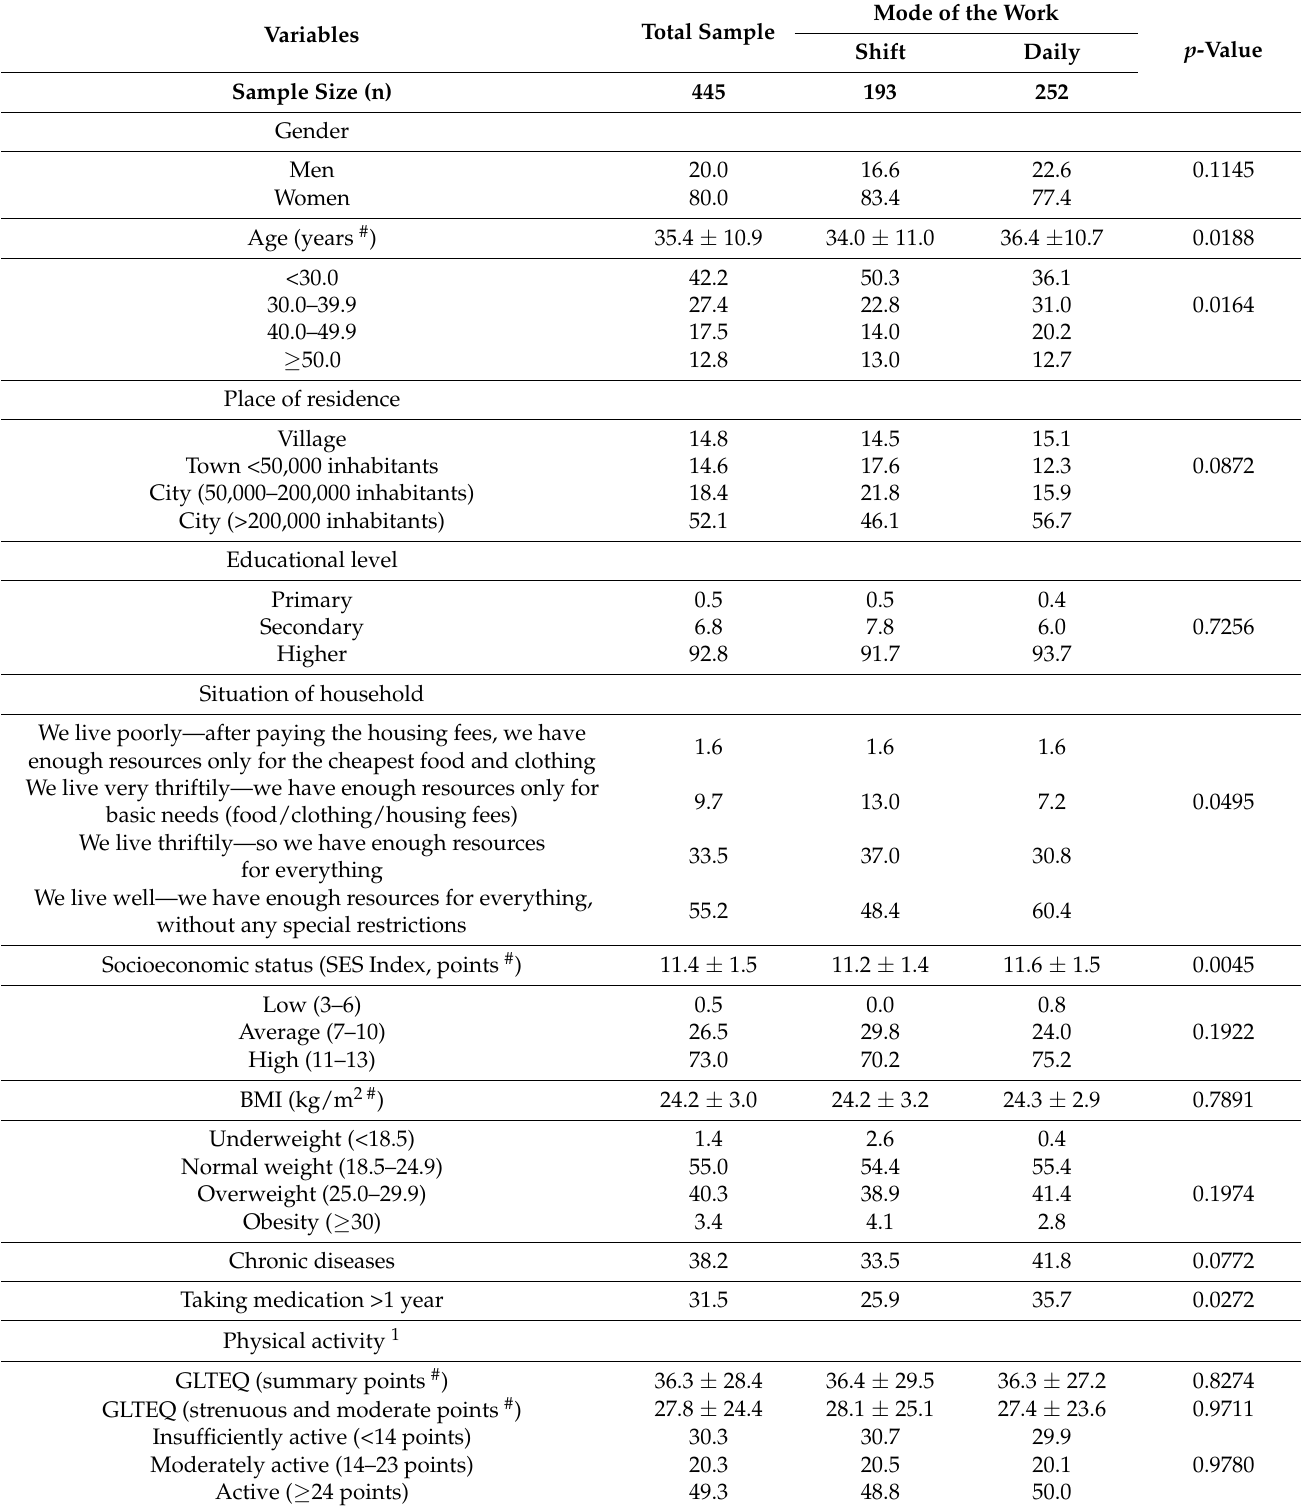
Table 2. Sample characteristics (% or mean ±